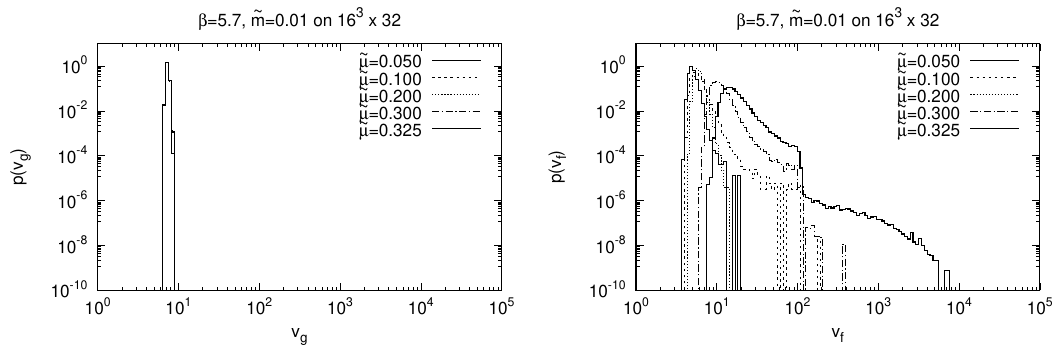
Figure 2 . The probability distributions p ( v ) of the drift term obtained from simulations on a 16 3 (cid:2) 32 lattice with (cid:12) = 5 : 7 and ~ m = 0 : 01 are plotted for the drift term v g coming from the gauge action (Left) and v f from the fermion determinant (Right).